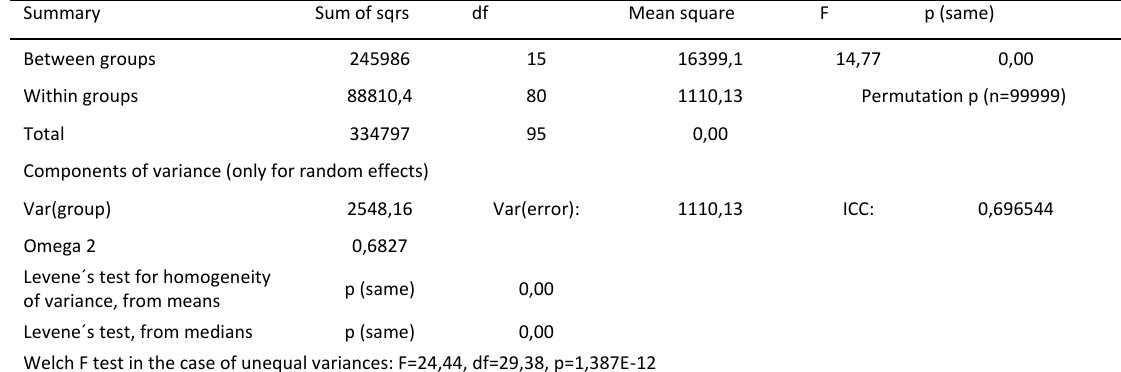
Tabel 2: Anova one way between location